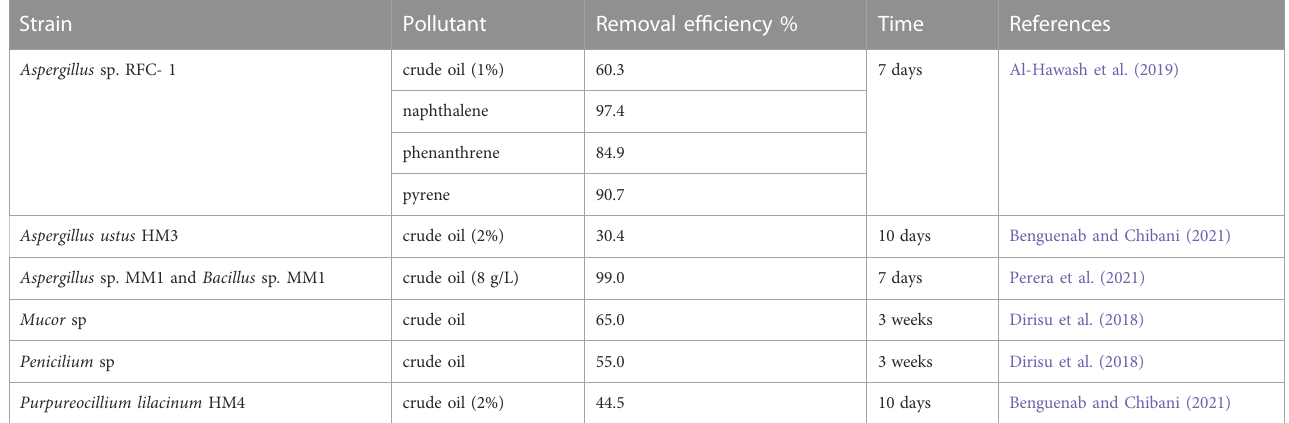
TABLE 4 Bioremediation of crude oil and hydrocarbons by fi lamentous fungi reported recently.